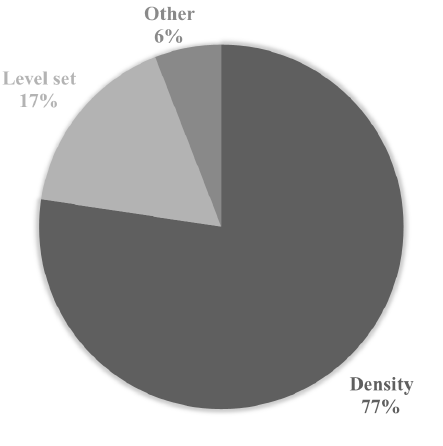
Figure 5. Distribution of papers in overall design representation type.